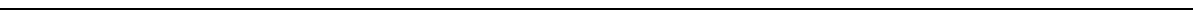
Fig. 4 HP1a is necessary for the proper splicing of piRNA precursors from selected clusters. a Ampli fi cation of regions from piRNA clusters at 42AB , 20F , and sox102F . Representative gel images of RT-PCRs show ampli fi cation and levels of the spliced and unspliced transcripts originating from clusters 42AB , 20F , and sox102F in HP1a-GLKD[2] ovaries. cuff- GLKD and krimp mutants were used as positive and negative controls, respectively. Three independent experiments were performed. b Spliced to unspliced transcript level ratio (SSR) calculated for the piRNA clusters 42AB , 20F , and sox102F . qRT-PCR was conducted with a primer set detecting either unspliced or spliced transcript. Three independent experiments were performed. The signi fi cance of difference in levels of spliced transcript between control and HP1a-GLKD[2] and between control and cuff-GLKD, ovaries was statistically tested using Mann-Whitney U test. n = 3, three independent biological replicates, error bars represent standard error for all replicates. p values: ** represent p value <0.05 and *** represent p value <0.005. c Boxplot showing the changes in the average FPKM values of spliced transcripts mapping to the piRNA clusters in the HP1a- GLKD[2] ovaries vs. the controls. d The average FPKM values of spliced transcripts mapping to the piRNA clusters in cytolocations 1, 20, 21, 40, 41, 60, 61, 80, 810, 100, and 102 with that in the clusters in rest of genome, in control and HP1a-GLKD[2] ovaries. e Fold increase in the spliced transcript coming from major piRNA clusters in HP1a-GLKD ovaries. f Representative confocal images of Rhi immunostaining in the control and HP1a-GLKD ovaries (left panel) and comparison of Rhi foci sizes between the control and HP1a-GLKD[2] ovaries (right panel). Scale bar = 5 μ m. Sixty egg-chambers from three biological replicates were analysed for the Rhi foci sizes. Statistical signi fi cance in differences of Rhi foci between the genotypes was examined using Kolmogorov-Smirnov test. For the boxplots in c – e , the middle line represents median. Box represents 25 – 75 percentile range called inter quartile range (IQR). Upper and lower whisker extend highest or lowest values till 1.5 * IQR. Values above and below are outliers and plotted